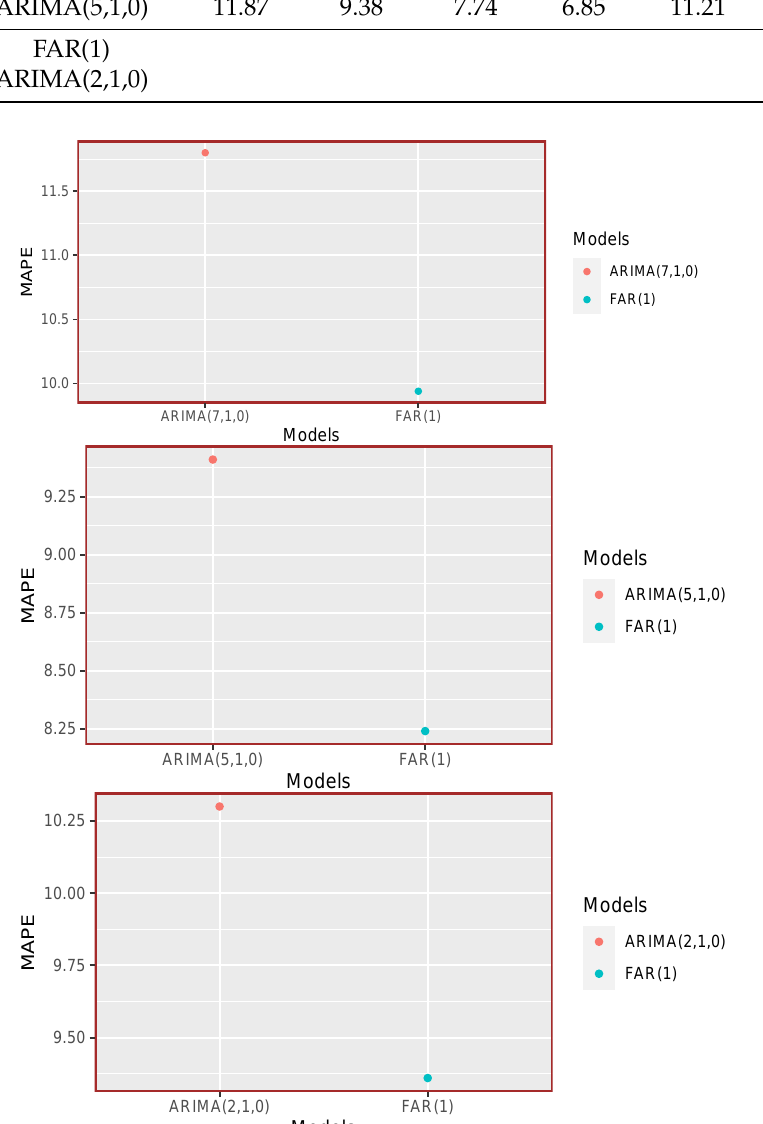
Figure 4. Out-of-sample forecasts MAPE values for traffic flow data by (upper panel) FAR(1) and ARIMA(7,1,0) for full data (middle panel) FAR(1) and ARIMA(5,1,0) for weekdays only and (lower panel) FAR(1) and ARIMA(2,1,0) weekends